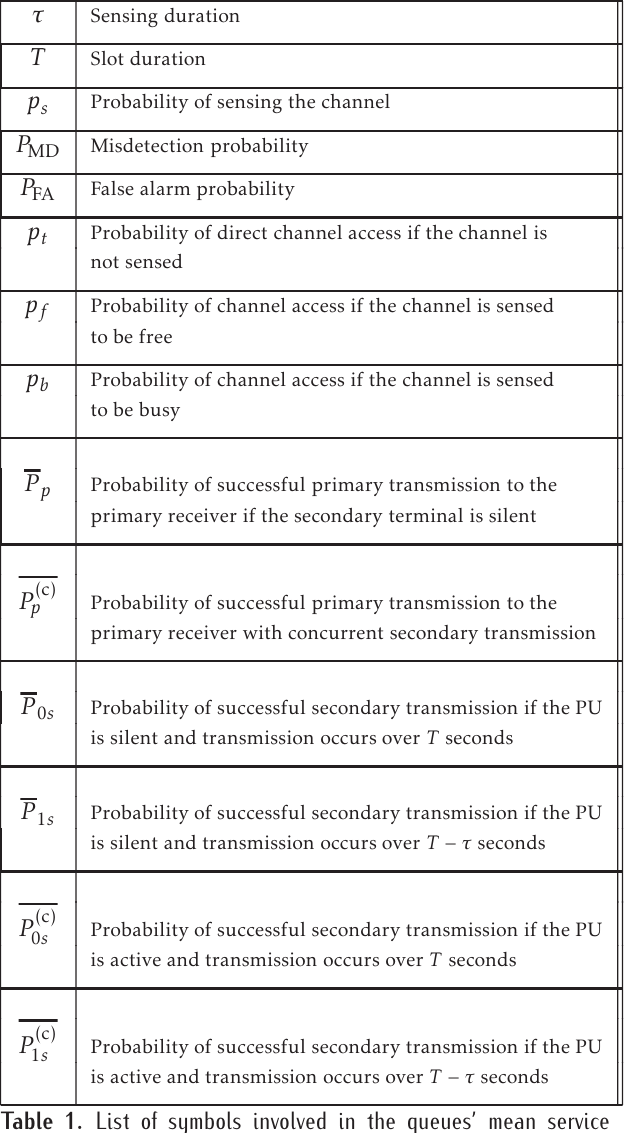
Table 1. List of symbols involved in the queues’ mean service